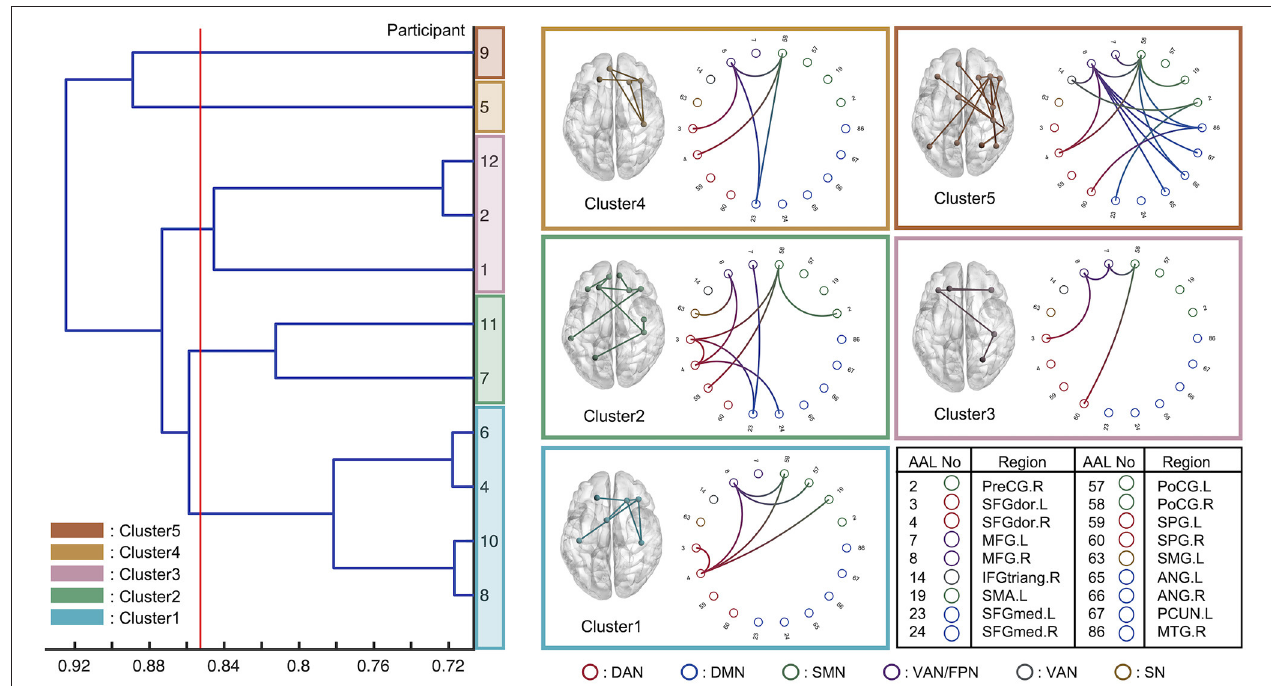
FIGURE 6 | Eleven individual models with sufficient prediction accuracy were classified using hierarchical clustering based on the functional connectivity chosen via feature selection. The horizontal axis indicates the Jaccard distance among the models. The red line was drawn to analyze the five clusters. The circle plot and connectome indicate the common functional connectivity edges within each cluster. Each node channel was associated with the brain region determined by automated anatomical labeling (AAL) atlas. The nodes are colored based on which well-known functional network they belonged to: DAN, dorsal attention network; DMN, default mode network; SMN, Sensorimotor network; VAN, ventral attention network; FPN, frontoparietal network; SN, salience